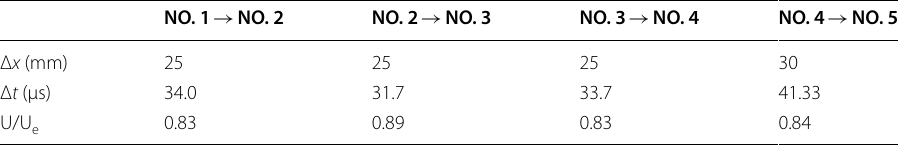
10E 6/m unit = + NO. 3 NO. 3 NO. 4 NO. 4 → →